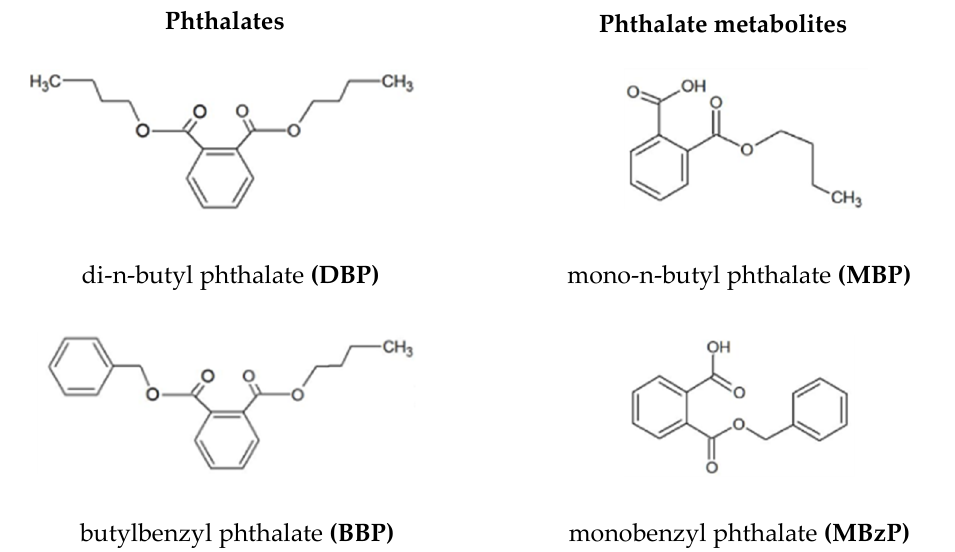
Figure 1. Chemical structures of the studied phthalates.